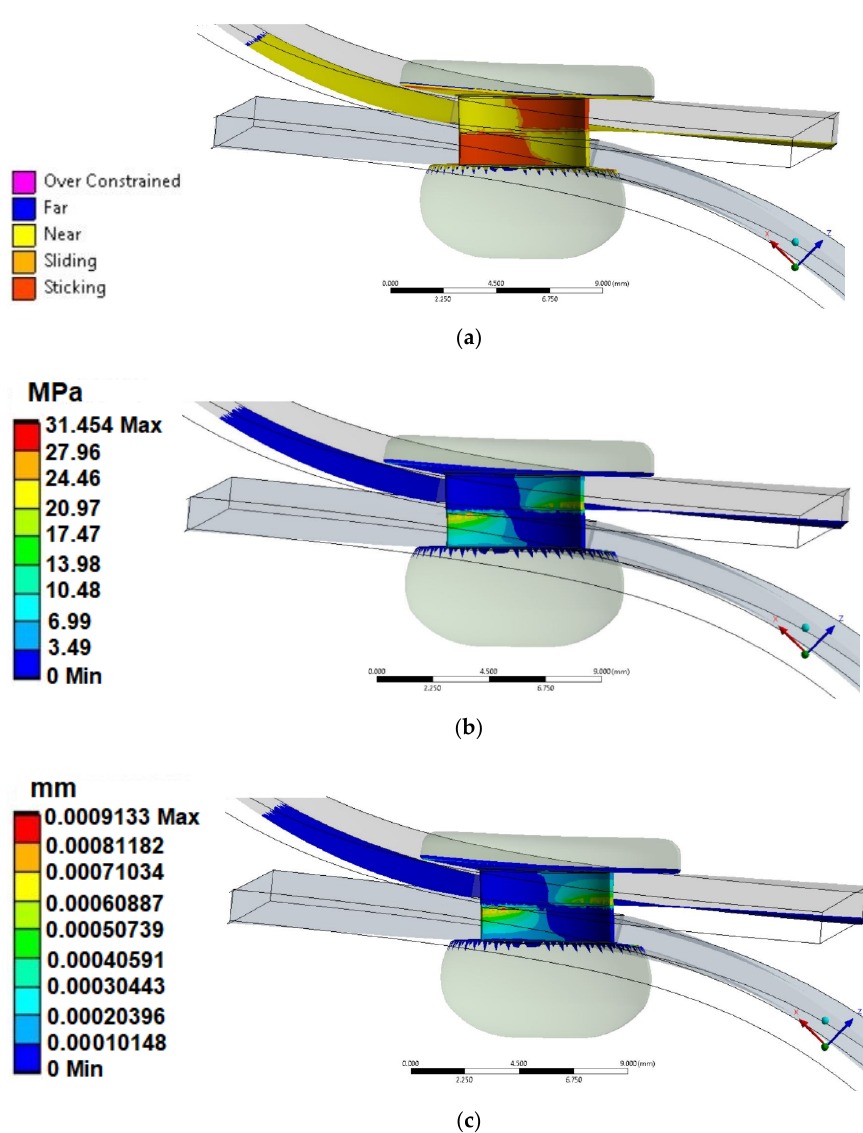
Figure 10. ( a ) Contact status; ( b ) contact pressure; ( c ) penetration.